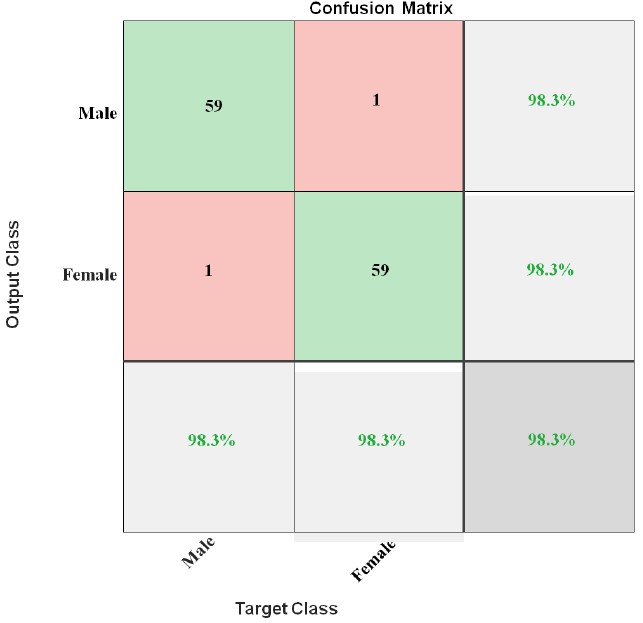
Figure 7. Confusion